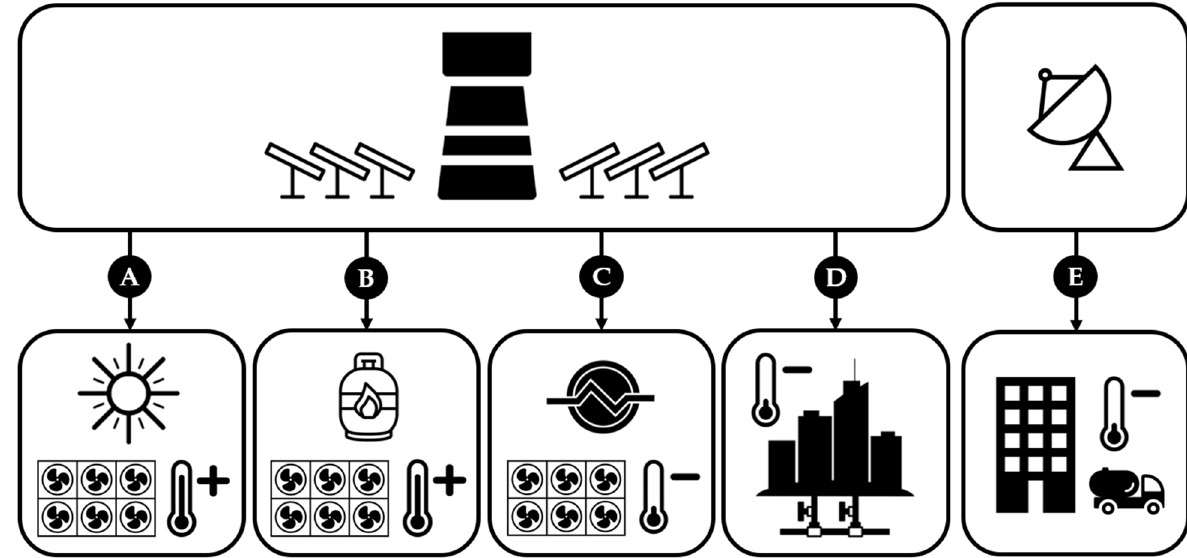
Figure 5. Overview of the five scenarios showing the concentrated solar thermal energy (CSTE) approach used in the upper part and the direct air capture (DAC) strategy in the lower part.